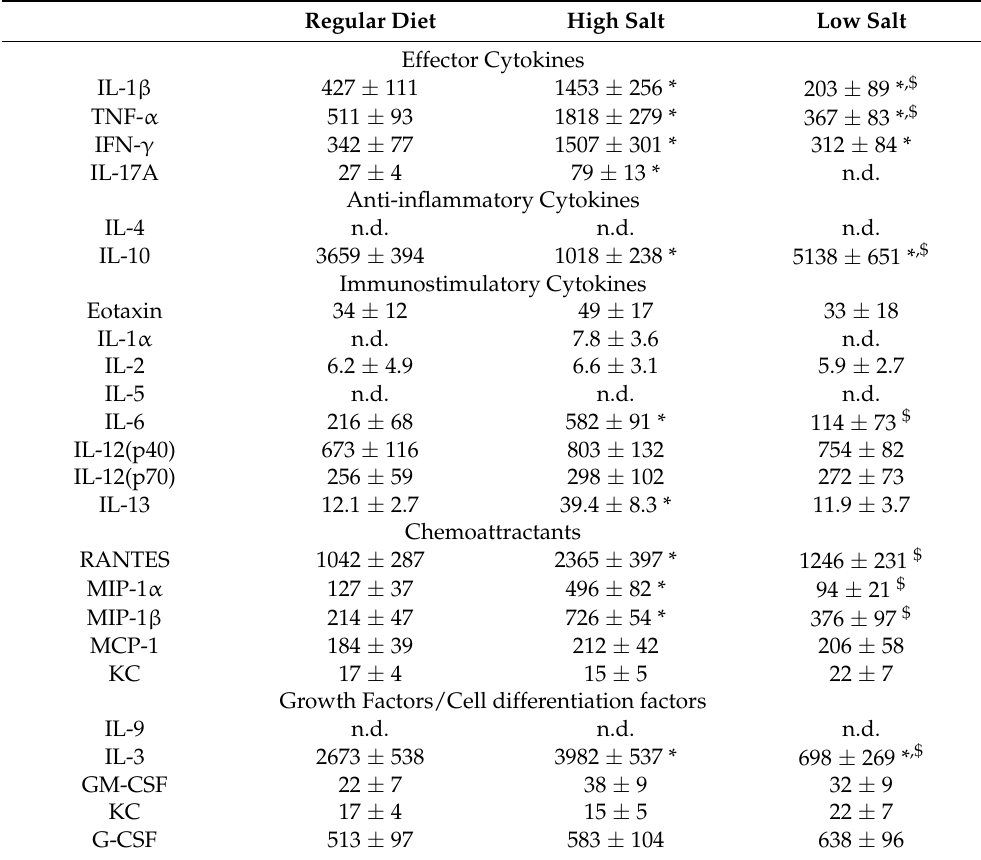
Table 1. Expression of cyto/chemokines in the blood (day 35) from breast-tumor-bearing mice following salt modified diet (NS, HS and LS). All experiments were performed in four independent biological replicates and protein values were presented as mean ± SEM, (*) p -value < 0.05 (ANOVA one-way post hoc Bonferroni correction, compared with NS cohort), ( $ ) p -value < 0.05 (ANOVA one-way post hoc Bonferroni correction, compared with HS